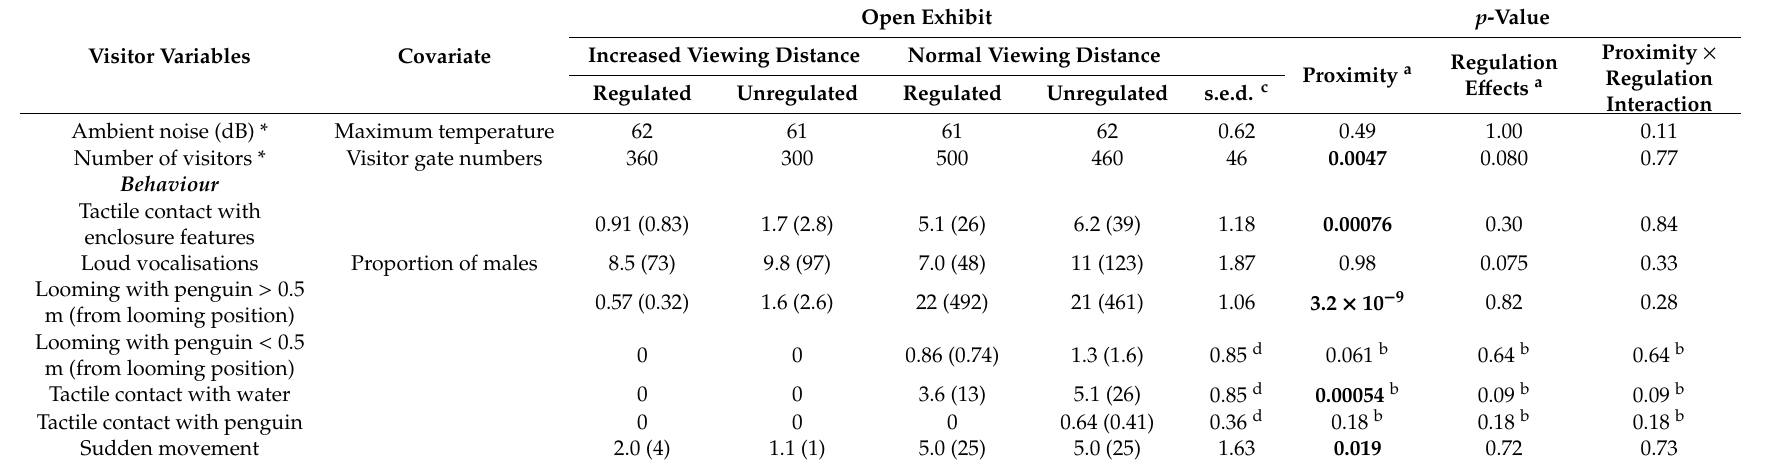
Table 3. E ff ect of treatment on visitor variables measured. The means shown are the mean frequency of visitor behaviours (per seven 30 min observations blocks per 2-day period) considered as events and ambient noise level per 2-day period. All measurements were square root transformed, except for ambient noise level and the number of visitors (*). Back-transformed means are presented in